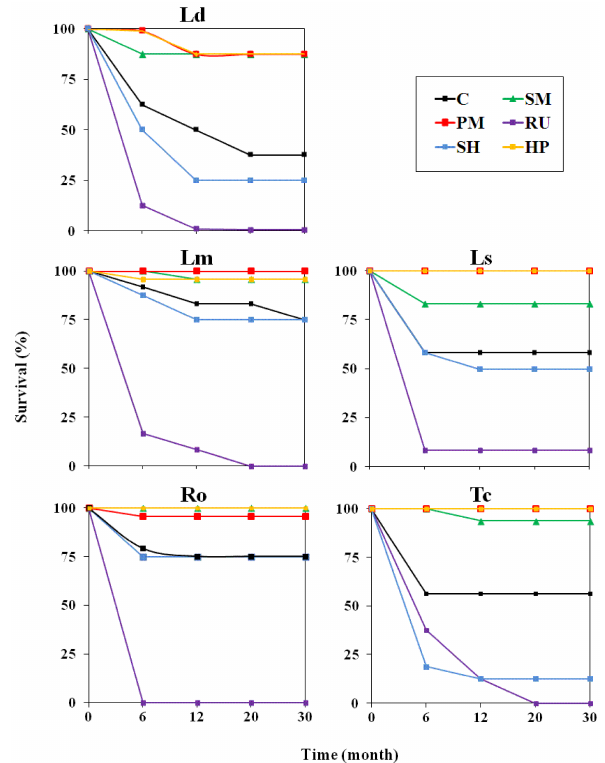
Figure 1. Survival rates (%) between amendments and control in the period 2011–2014. C: soil afforested and not amended; PM: mulch with chipped branches of Aleppo pine ( Pinus halepensis L.) ; SM: straw mulch; RU: sewage sludge; SH: sheep manure compost; HP: